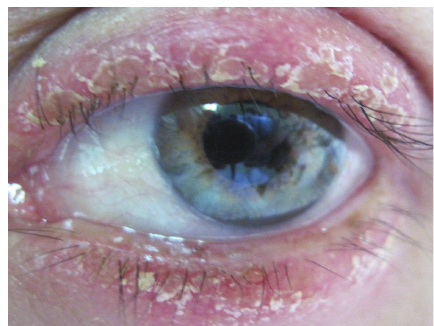
Figure 1: Blepharitis caused by Trichophyton ajelloi.